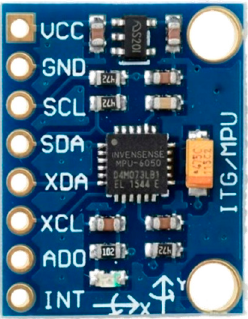
Figure 8. MPU-6050 six-axis sensor.